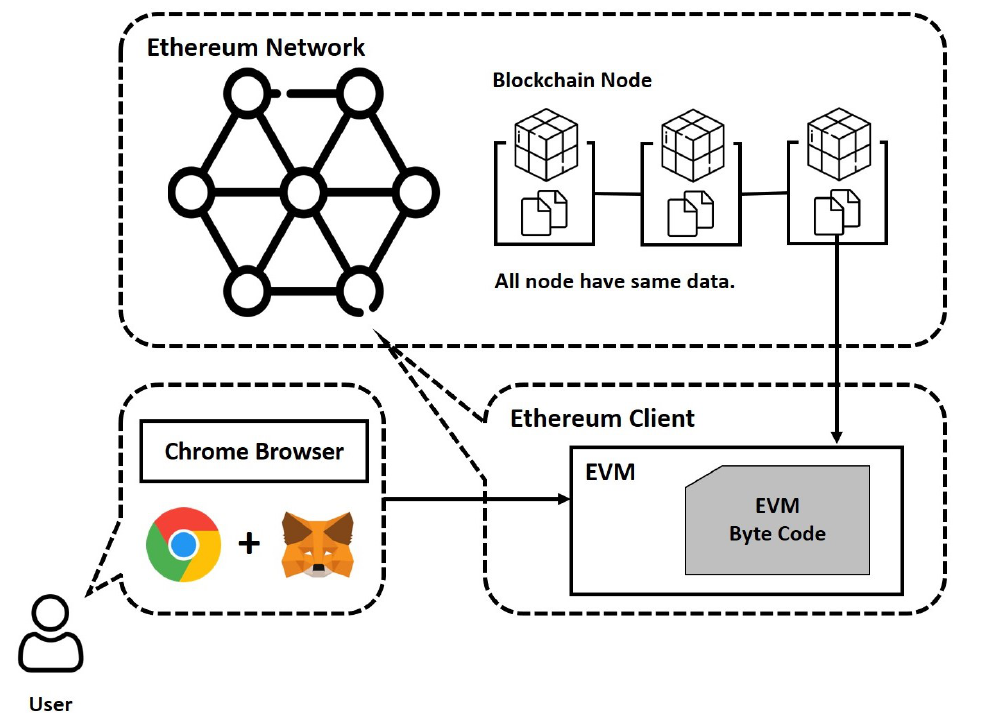
Figure 3. Ethereum